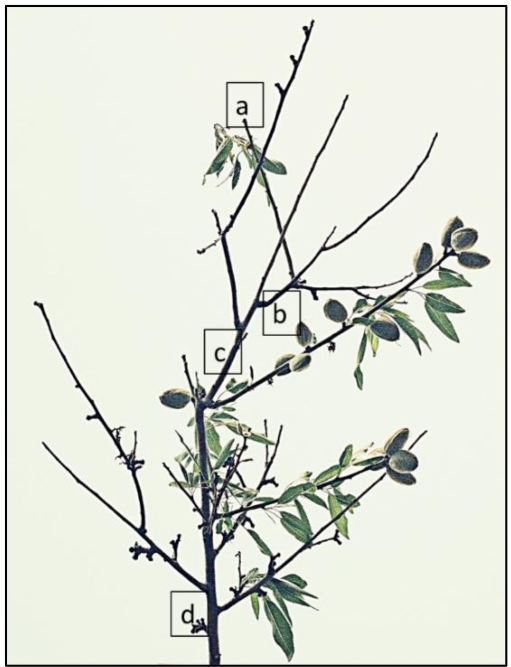
Figure 2. Shoot expression of NBF. Terminal vegetative buds fail to grow shifting growth to a sub-apical bud (a). The pattern is repeated here with three previous seasons’ shoot growth-failures (b, c, and d, respectively) present, resulting in a distinct pattern known as ‘crazy-top’. Note that flower buds are not directly a ff